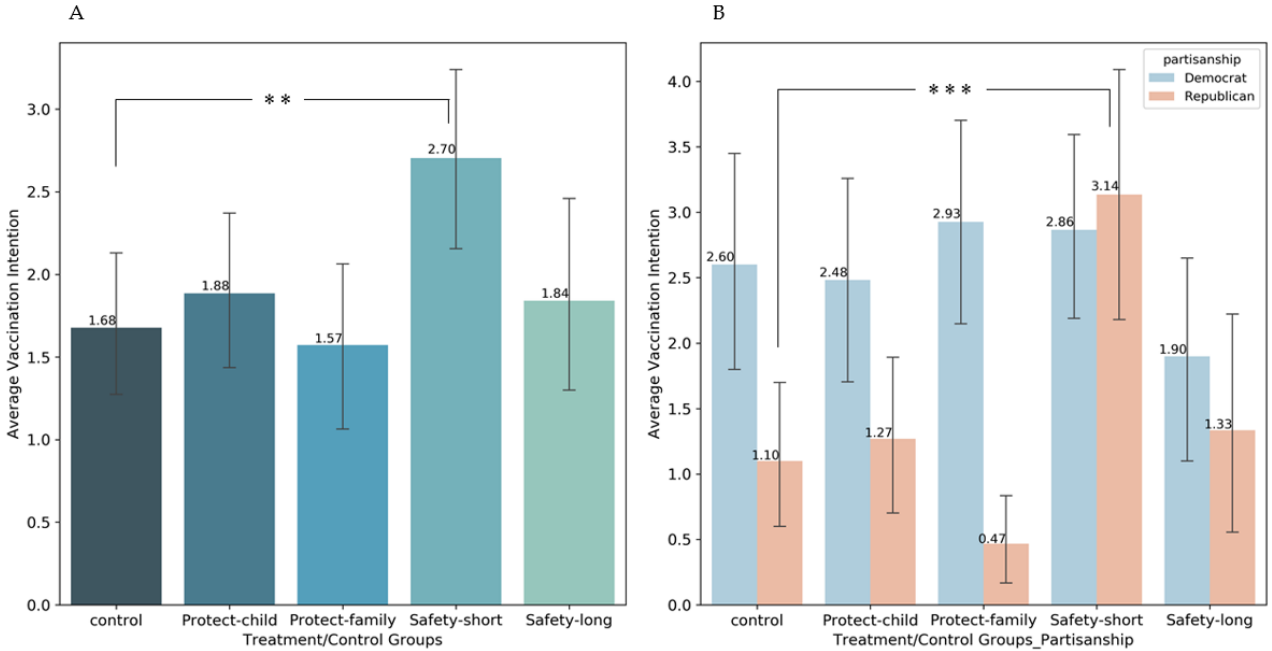
Figure 1. Average vaccination intention of parents in different groups. ( A ). Average vaccination intention of parents in different groups by whole sample; ( B ). Average vaccination intention of parents in different groups by partisanship. Error bars reflect ±1 SEM. ** p < 0.05, *** p < 0.01.